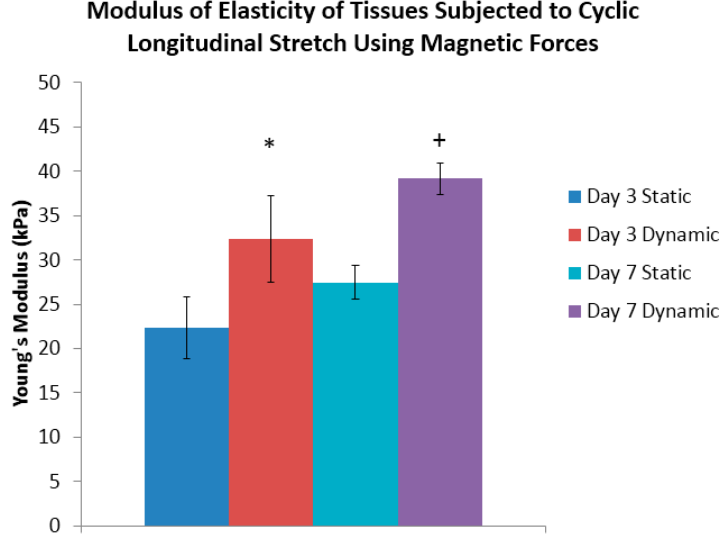
Figure 4. Tissue sheet mechanical properties. Atomic force microscopy of the tissue sheets demonstrating a significantly higher Young’s modulus of the dynamically-conditioned tissue sheets at both time points as compared to statically-conditioned controls: n = 3 tissue samples tested per group (“*” and “+” indicate the statistical significance).